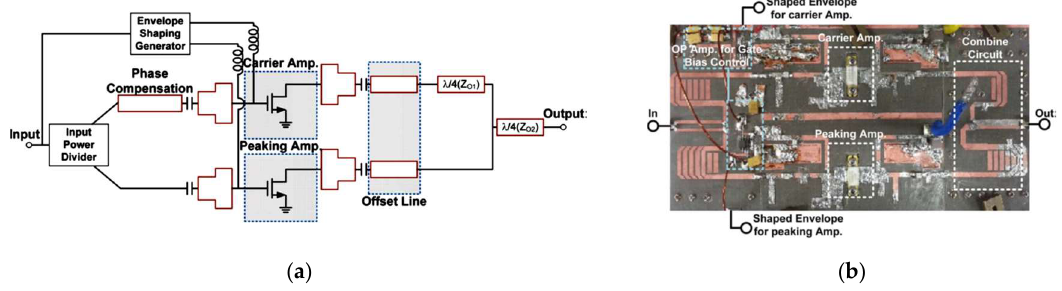
Figure 3. ( a ) Schematic of the Doherty amplifier with gate-bias adaptation, ( b ) A model of fabricated Doherty Power Amplifier (DPA) and presented in [32].